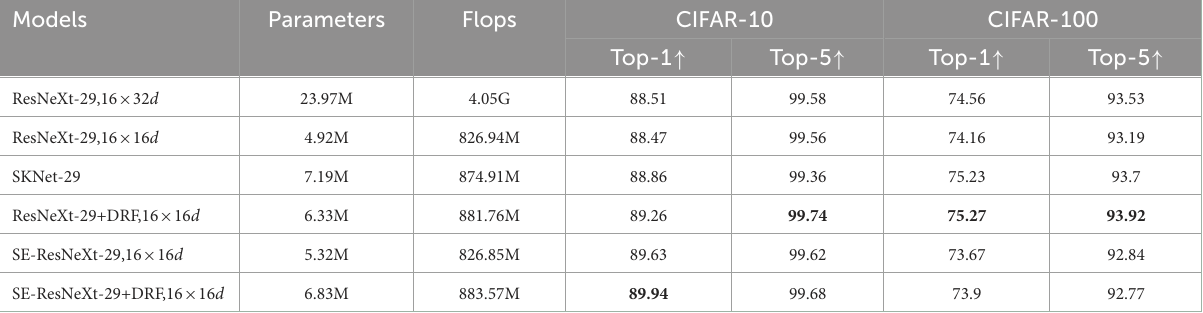
TABLE 9 Top-1 accuracy and Top-5 accuracy on CIFAR-10 and CIFAR-100 of the proposed DRF-based network when being evaluated on an image recognition task.